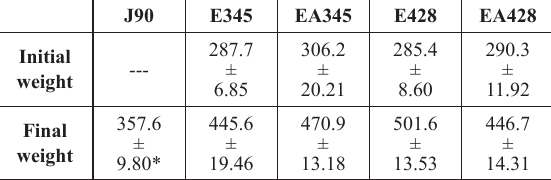
Initial and final body weight (g) of rats in groups: J90 (90-day- old young rats), E345 (345-day-old aged rats), EA345 (345-day- old aged rats treated with ascorbic acid since 90-day-old), E428 (428-day-old aged rats) and EA428 (428-day-old aged rats treated with ascorbic acid since 90-day-old). n = 5 rats per